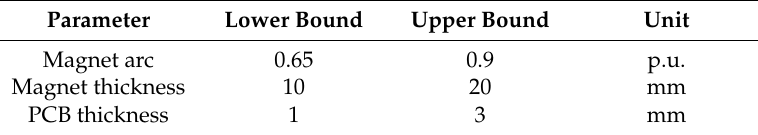
Table 1. Limits of the search space adopted for the optimization.